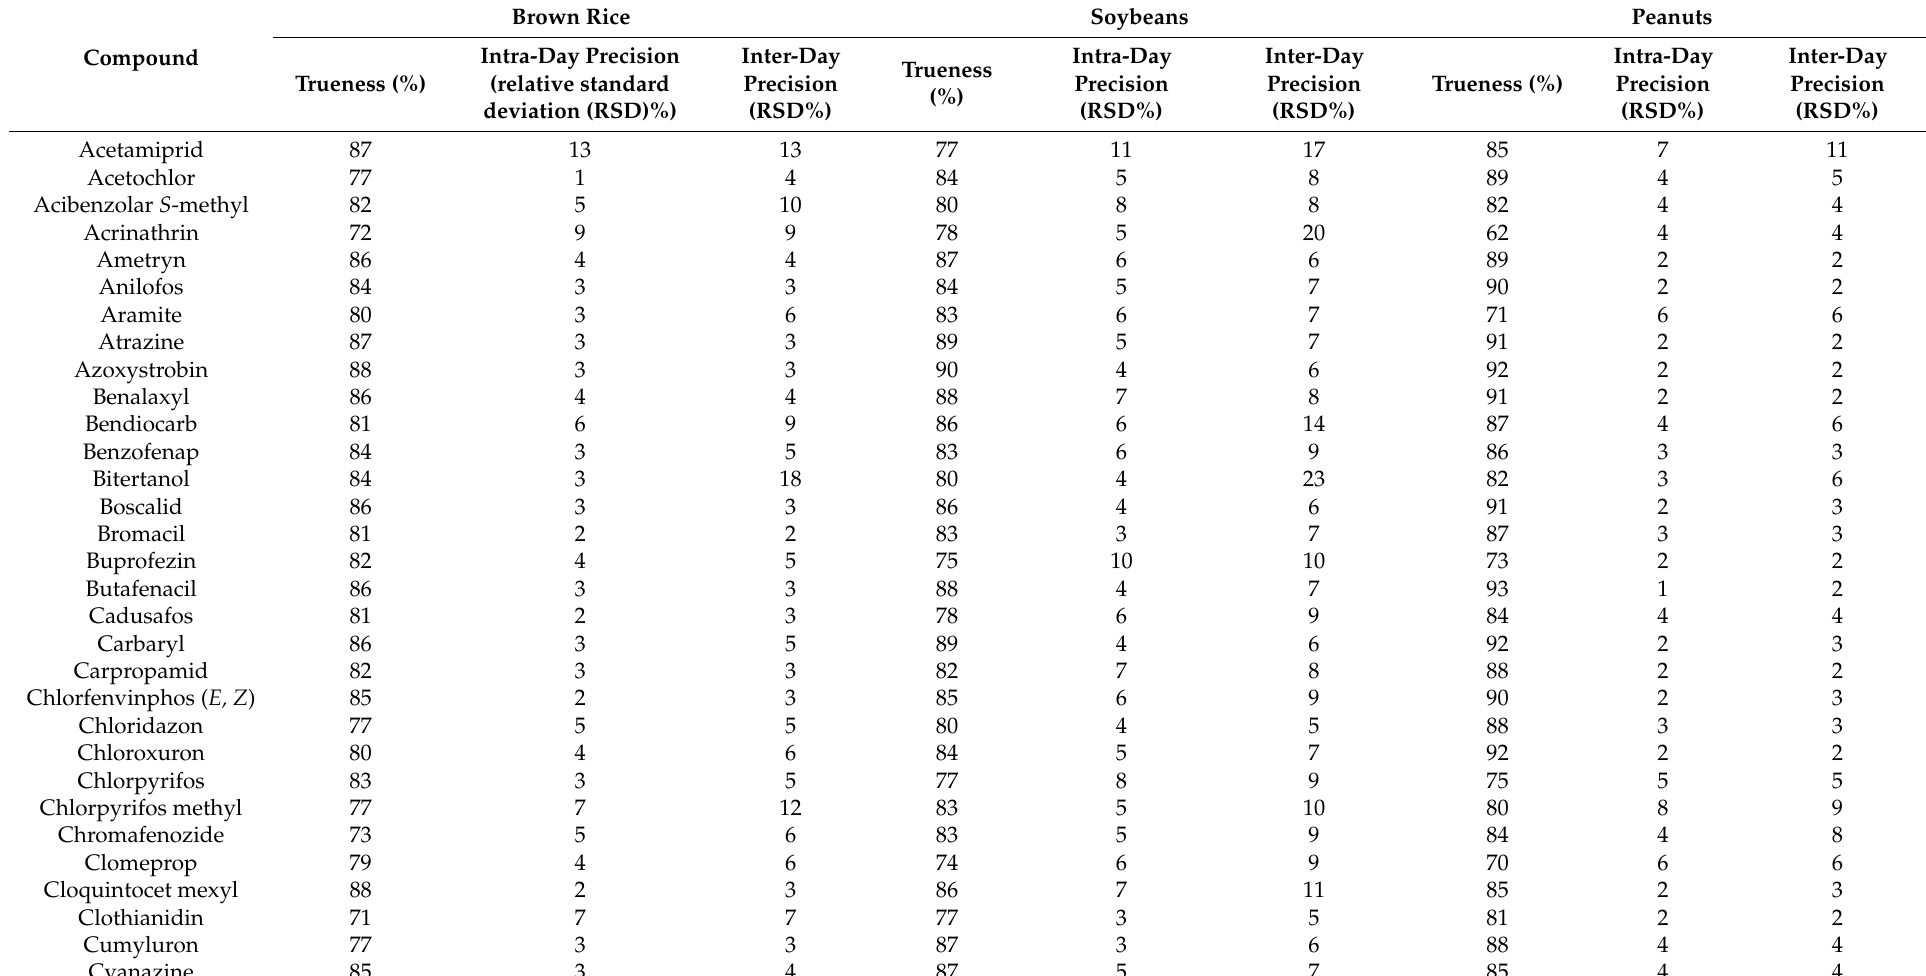
Table 2. Trueness and intra- and inter-day precision of the target